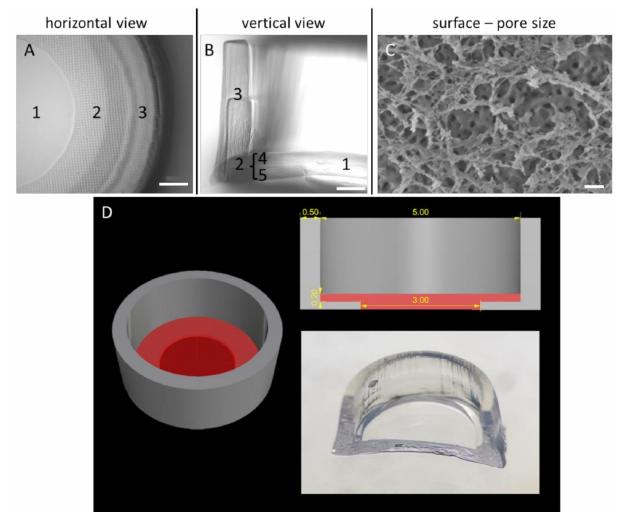
Figure 1. Morphological and structural characterisation of the Wellbrick matrix. ( A ) Partial microscopic view onto the matrix surface. The growth area of the Wellbrick is divided into (1) a “viewing window” for light microscopy consisting of gelatine only and (2) a hybrid area consisting of gelatine supported by a layer of polyethylene glycol (PEG). The boundary of the Wellbrick (3) consists of PEG only. ( B ) Vertical cut through a Wellbrick. The outer PEG boundary (3) is printed in two layers on top of each other. The hybrid growth area is separated into two equal parts of an upper gelatine layer (4) supported by a layer of PEG (5) as physical support. ( C ) Cryo-scanning electron micrograph of partially freeze-dried gelatine surface. The surface layer was completely dried and reveals a fine mesh-like structure which is partially destroyed by the freeze-drying process. Below this layer, a surface with distinct pores is visible which are most likely surrounded by fully hydrated, frozen gelatine. Scale bar ( A , B ) = 500 µ m. Scale bar ( C ) = 200 nm. ( D ) Dimensions and shape of Wellbricks model. The photography shows a cut through the centre of a Wellbrick. The length specifications on the CAD image at the top right are indicated in